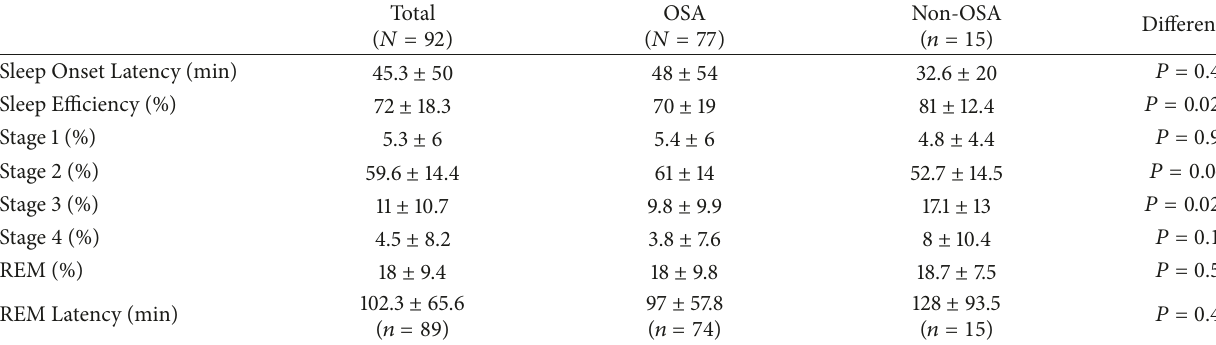
Table 1: Sleep macro-architecture for the study sample during first night of ambulatory